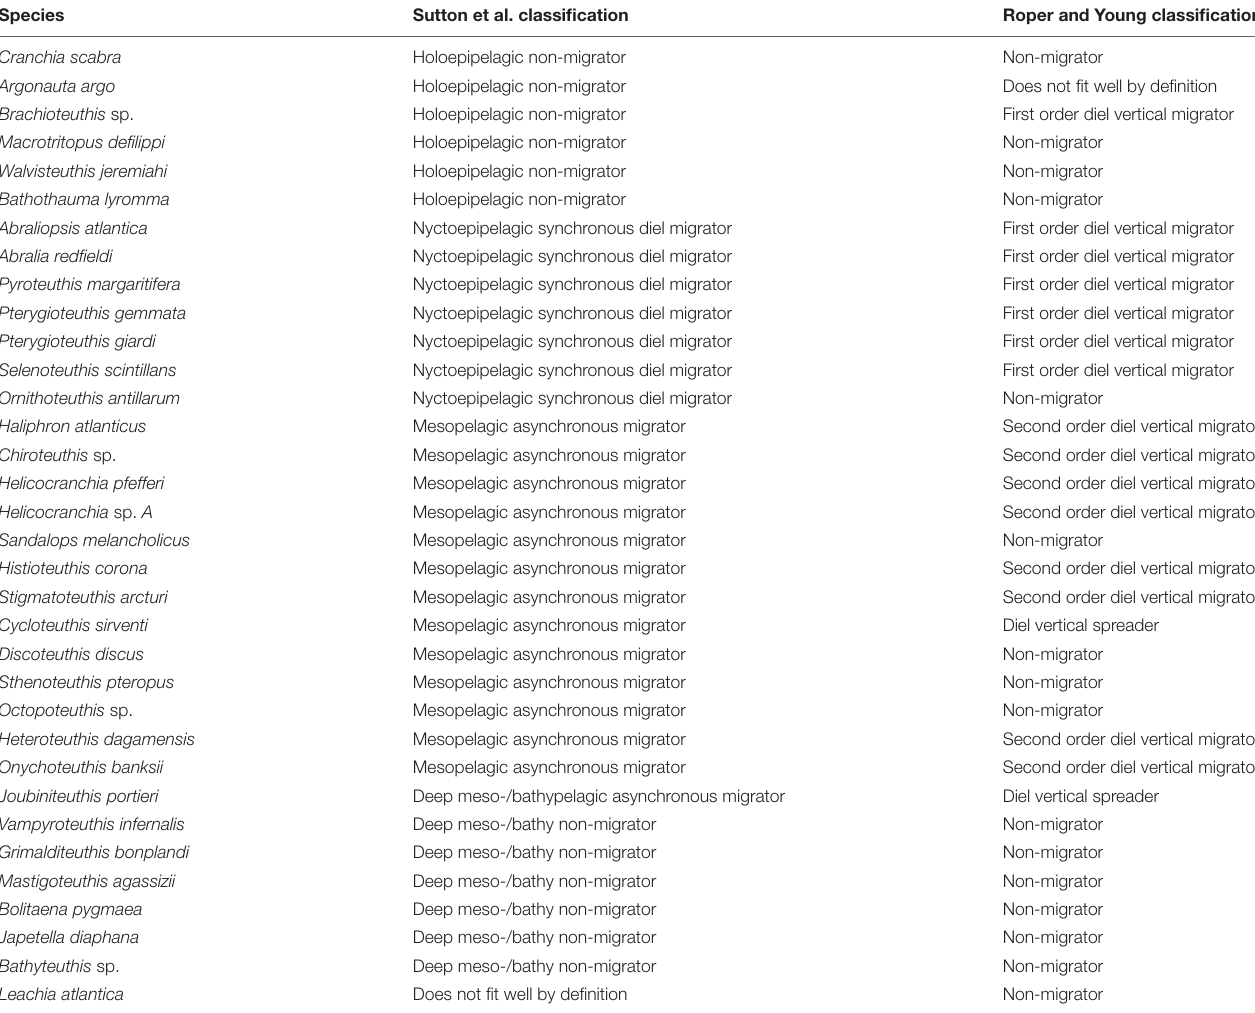
TABLE 3 | Current study species and our placement of cephalopods within the vertical migration pattern categories according to T. Sutton et al. (unpublished) and Roper and Young (1975).